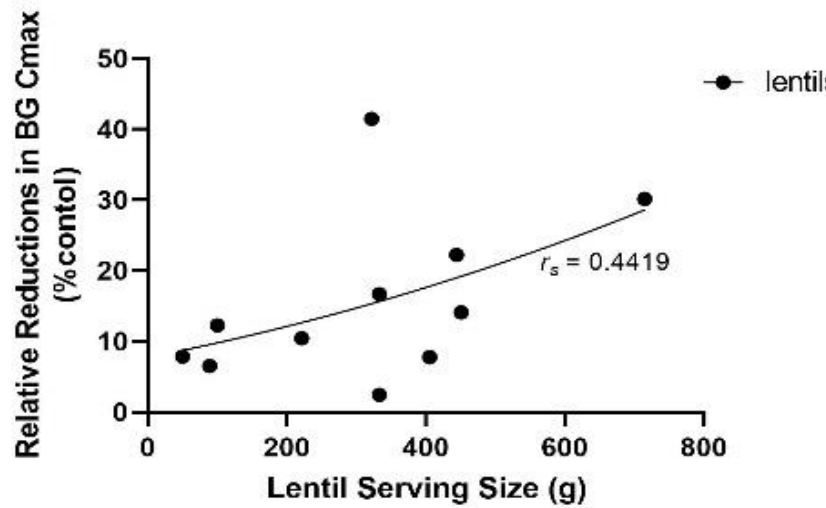
Figure 9. Relative reductions (%) of blood glucose maximum concentration (BG Cmax) according to the lentil serving size (g) in the lentil treatment group with respect to the control group. A quadratic model best fit this data ( r s = 0.4419; n = 11; ns ).